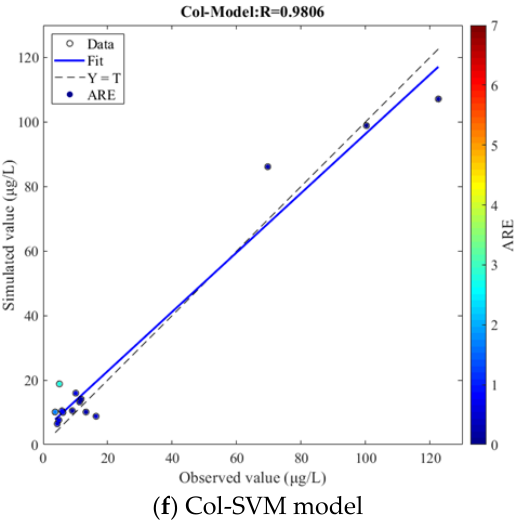
Figure 2. The testing results comparison of each model.